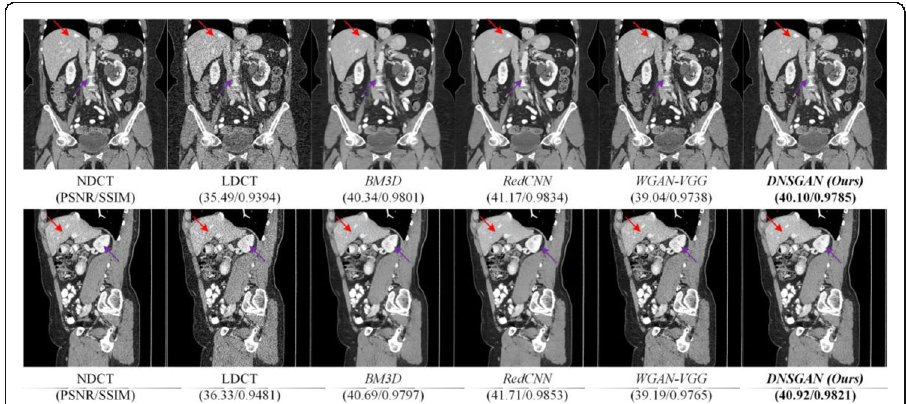
Fig. 7 The coronal and sagittal images reconstructed by different methods for comparison. The top row is the result in coronal plane and the bottom is in median sagittal plane. Red and purple arrows indicate the regions with visually distinguishable details for different methods